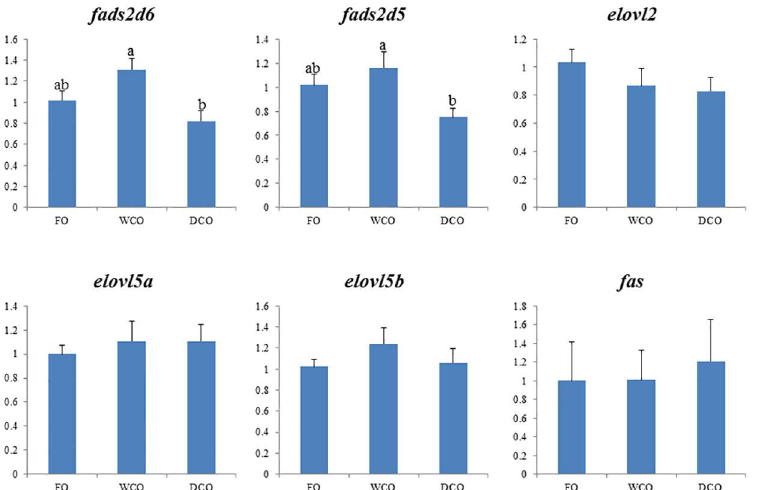
Fig 7. Expression of genes of the LC-PUFA biosynthesis pathway in liver of Atlantic salmon as determined by qPCR. Results are normalizedexpression ratios (means ± SEM; n = 6). FO, fish oil diet; WCO, wild type camelinaoil diet; DCO, EPA+DHA camelinaoil diet. fads2d6 ,delta-6 fatty acyl desaturase; fads2d5 ,delta-5 fatty acyl desaturase; elovl2 , fatty acyl elongase2; elovl5a ,fatty acyl elongase 5 isoform a; elovl5b ,fatty acyl elongase 5 isoform b; fas , fatty acid synthase. Different superscript letters denote differences amongtreatments identifiedby one-wayANOVA.